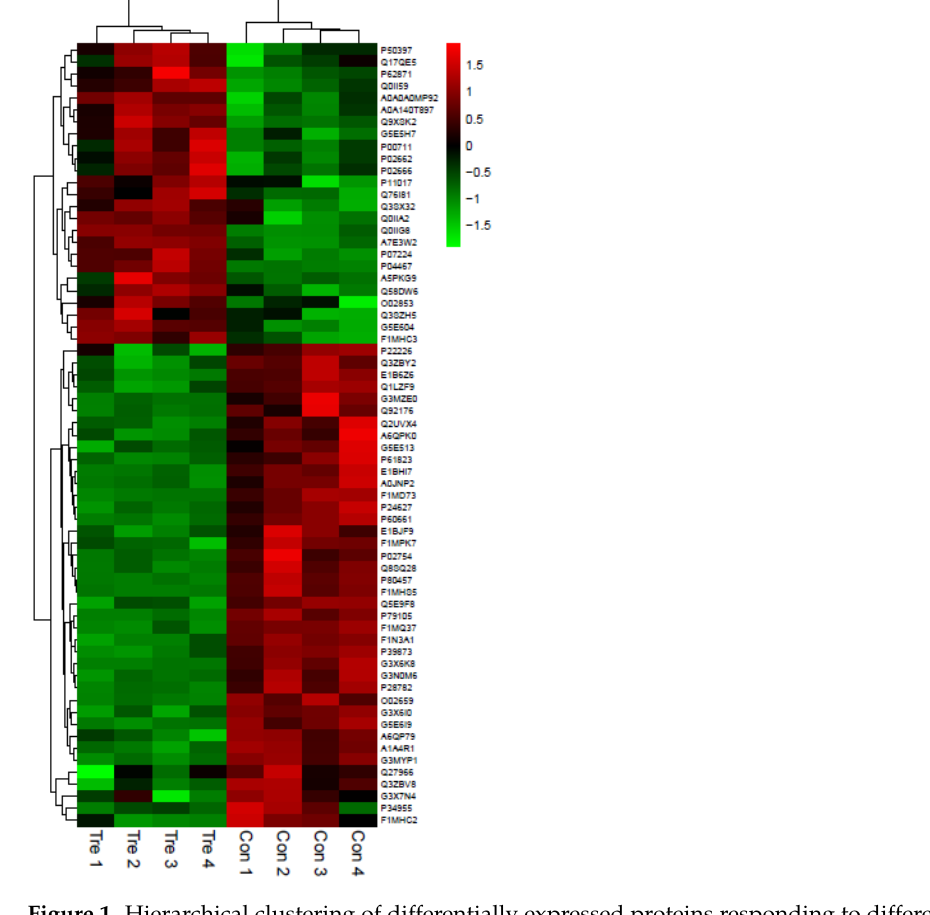
Figure 1. Hierarchical clustering of differentially expressed proteins responding to different diets. Each grid represented a protein, and protein abundance intensities were represented in red and green for high abundant and low abundant, respectively.